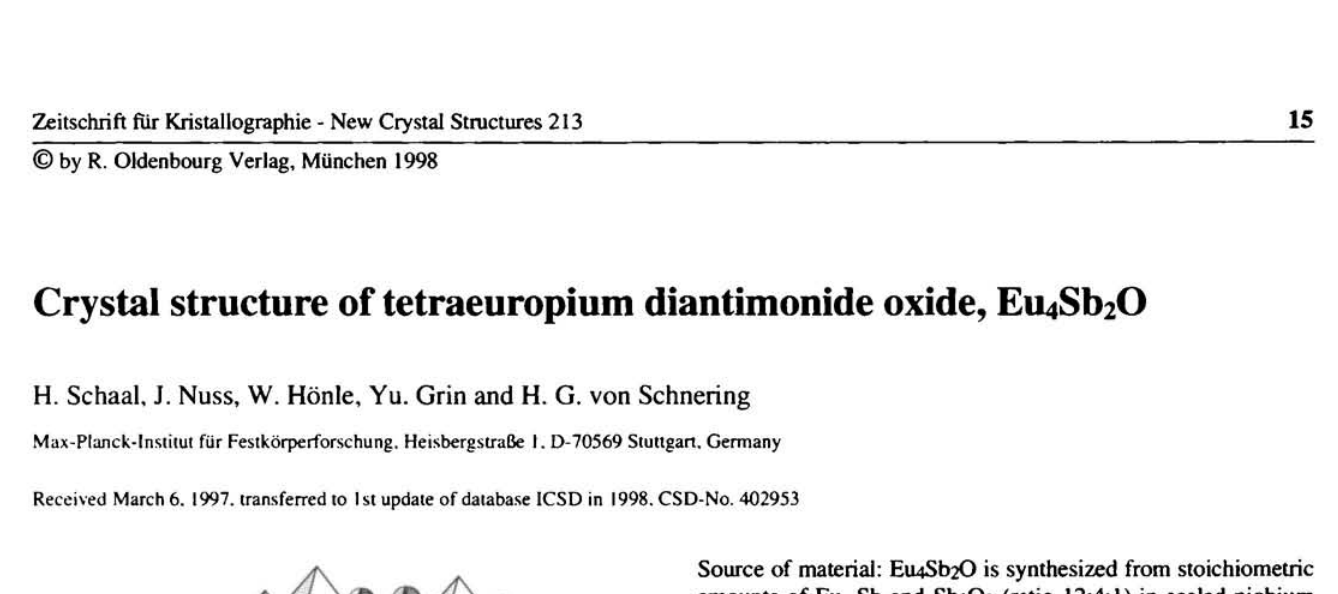
Table 1. Parameters used for the X-ray data collection